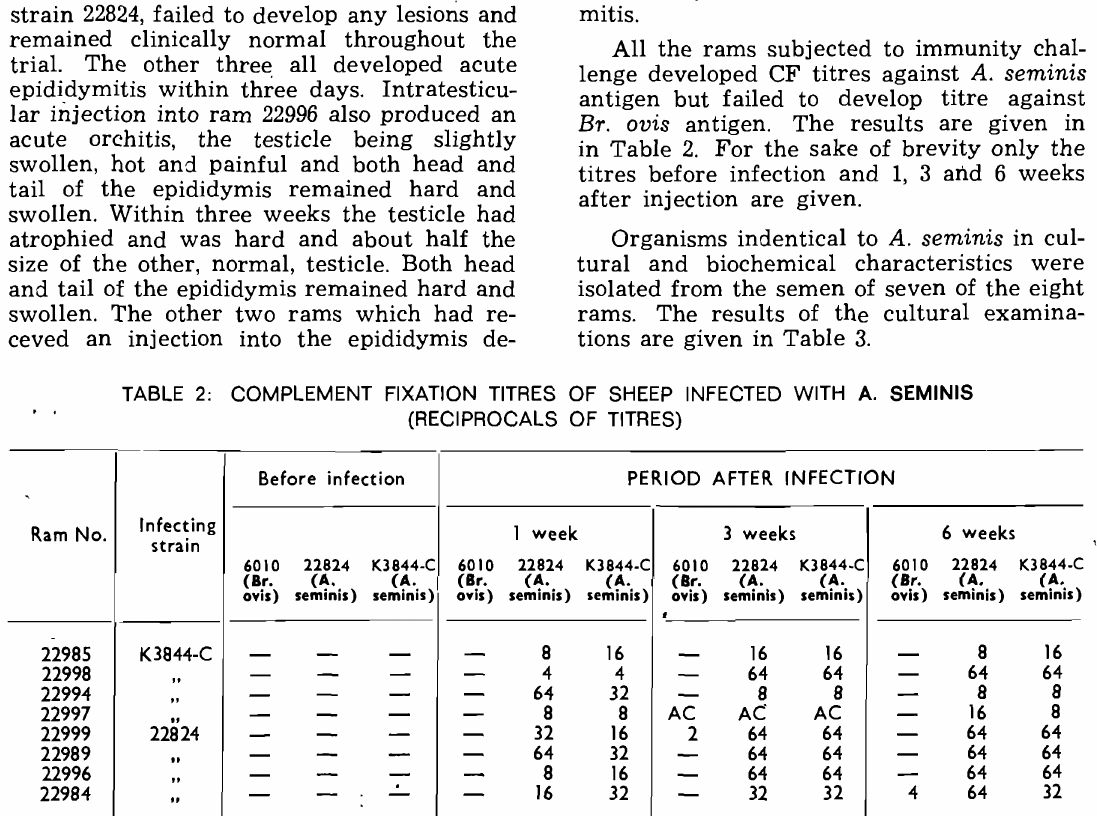
TABLE 3: ISOLATION OF A. SEMIN/S FROM THE SEMEN OF a EXPERIMENTALLY INFECTED RAMS Ram